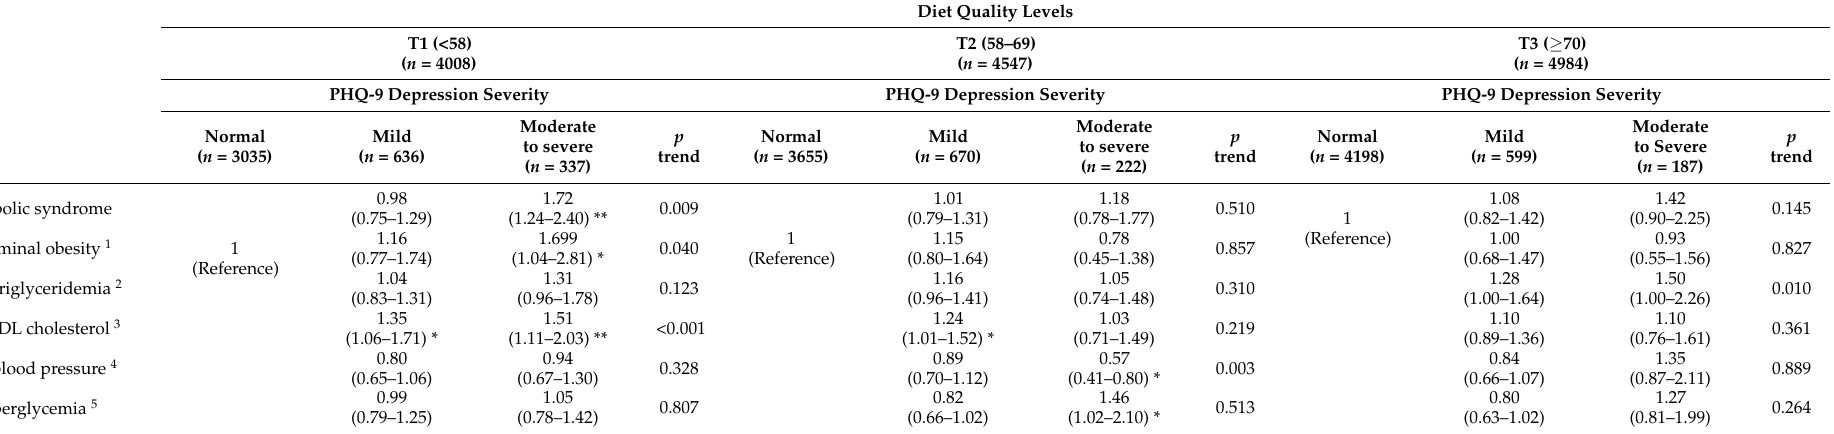
Table 8. Adjusted odds ratios (95% confidence intervals) for risks of metabolic syndrome and its components of subjects according to depression severity after stratified by diet quality levels measured by the Korean Healthy Eating